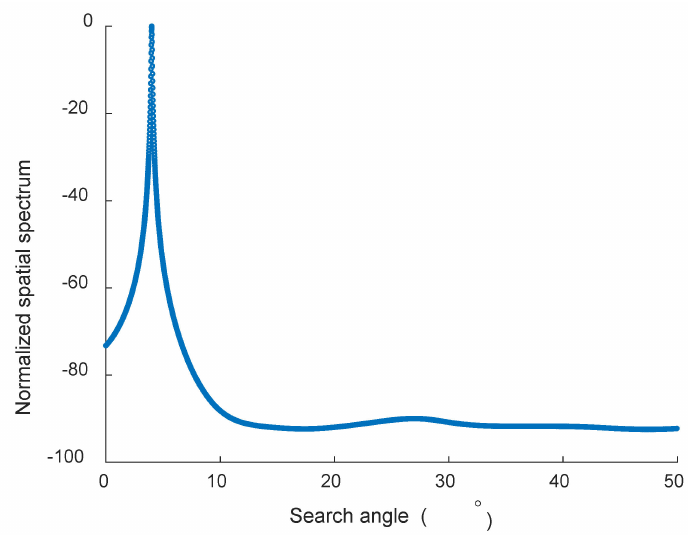
Figure 3. Estimation results of generalized MUSIC full space search.